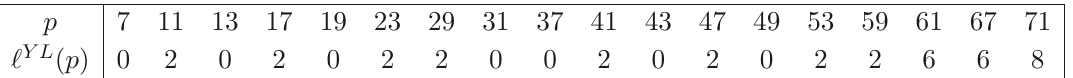
Table 1 . Number of zeros in the modular Wronskian for Hecke images under T p of Yang-Lee characters for small values of p .